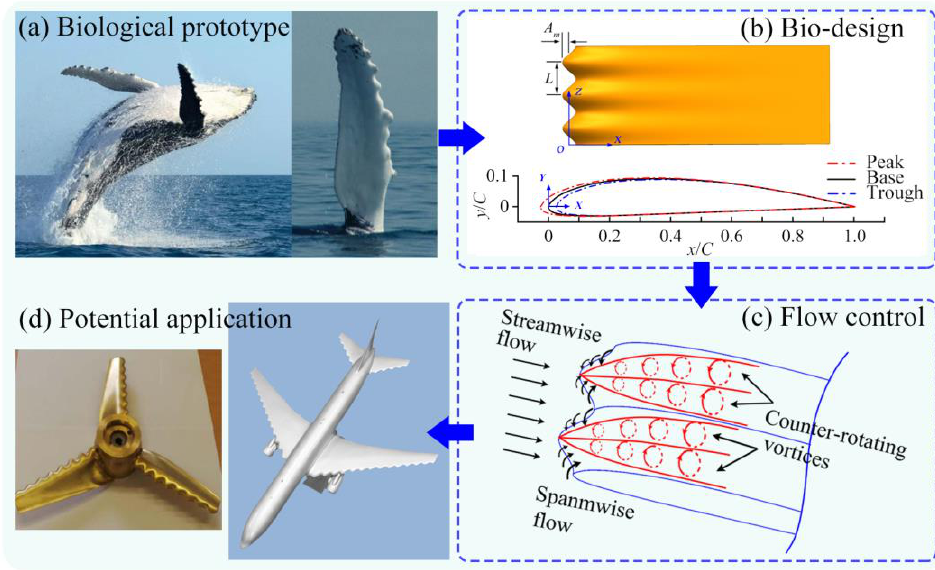
Figure 1. Humpback whales’ pectoral flippers ( a ), geometric features of the modified hydrofoil ( b ), control mechanism of boundary layer flows ( c ), and potential applications ( d ).